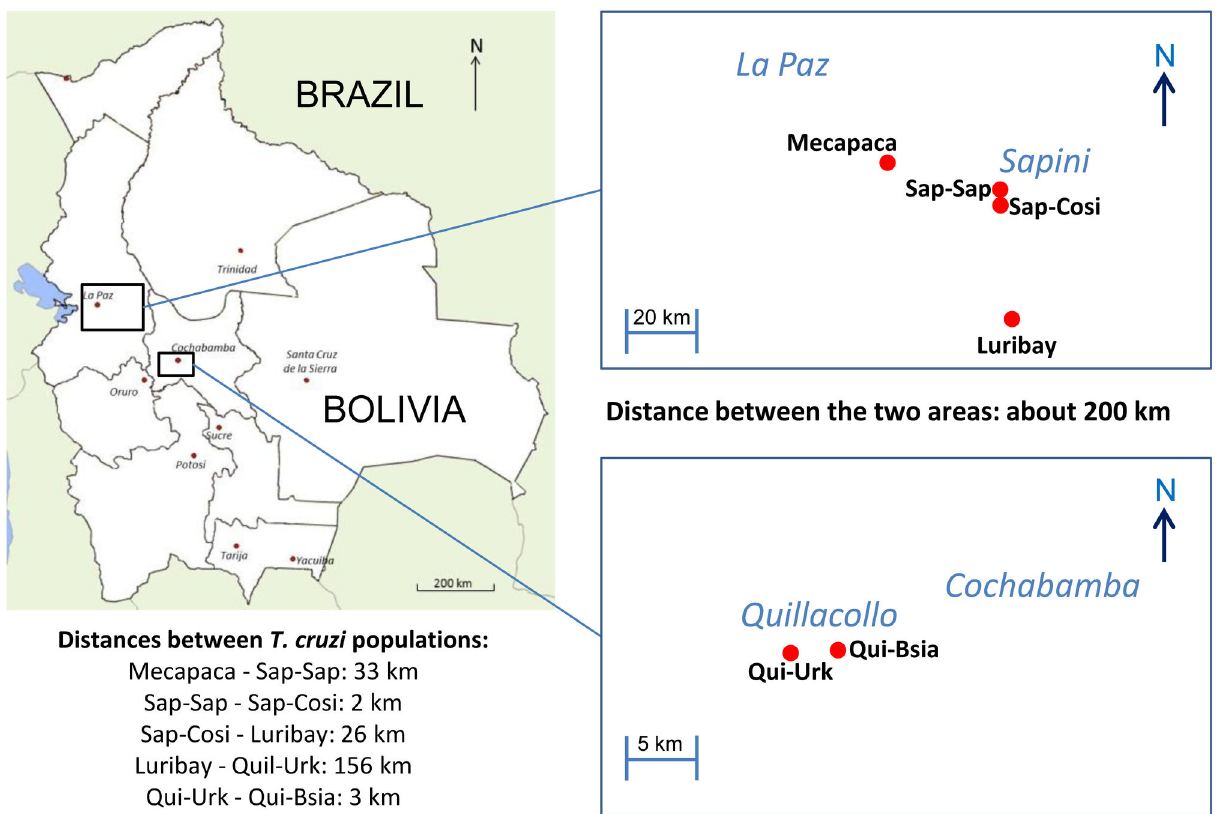
Figure 1. Map of Bolivia: localization of the six populations of Trypanosoma cruzi under study isolated from sylvatic Triatoma infestans and distances between populations. doi: